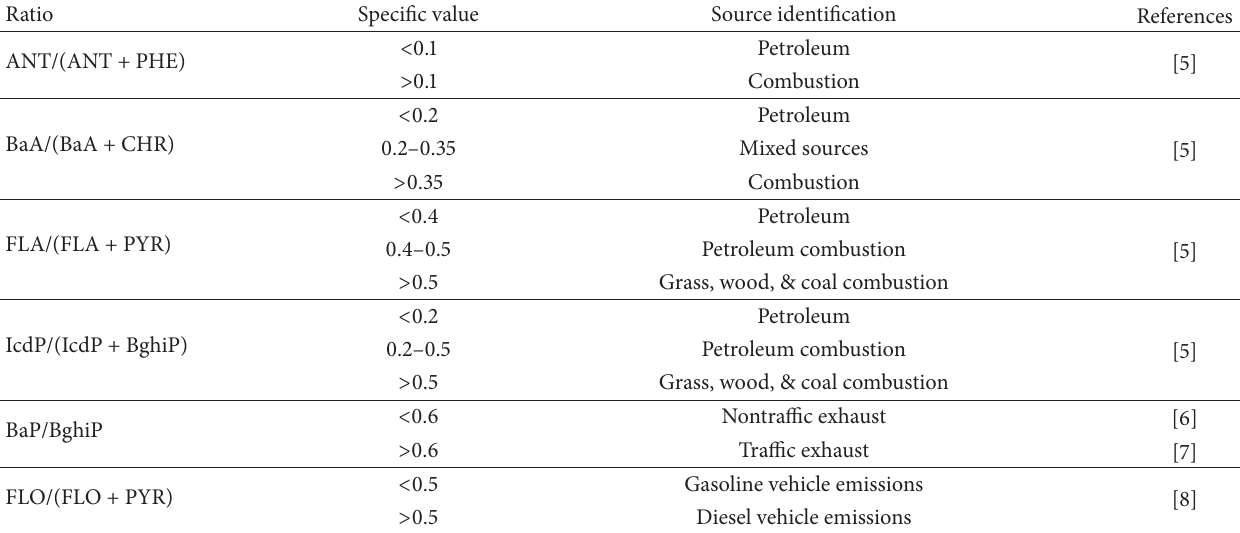
Table 1: Typical diagnostic ratios and corresponding judge